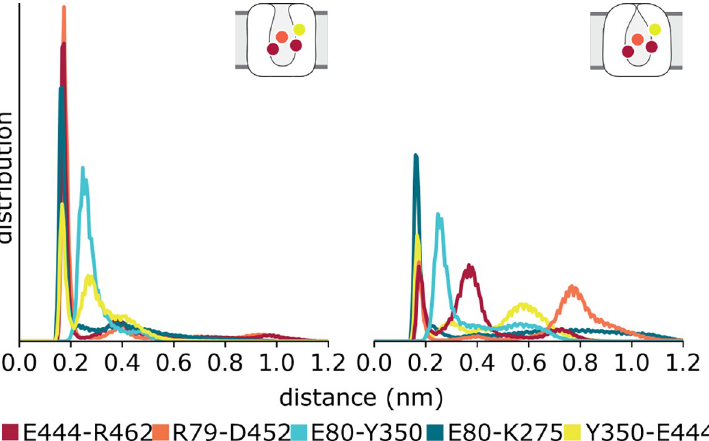
Fig 9. Distances between residues forming the intracellular gates during molecular dynamics simulations of hSERT. Residues in the cytoplasmic ends of TM5, TM6, TM8, TM9, and the N-terminus were tracked in simulations of the outward-open (left) and outward-occluded (right) states. The normalized distributions of distances between these gate-forming residues reveal a higher number of hydrogen-bond breaking events in the outward-occluded